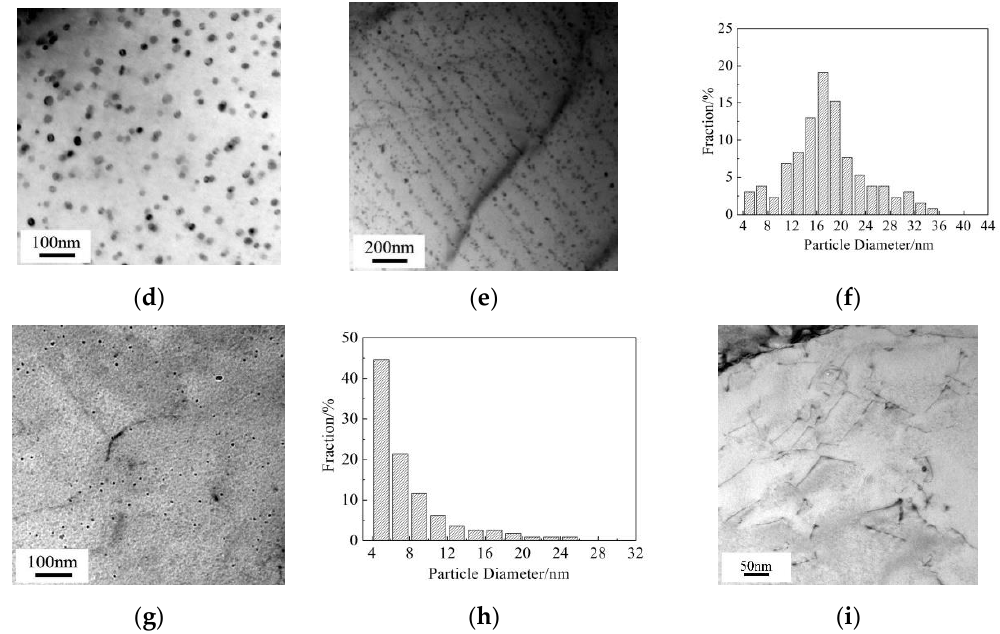
Figure 4. TEM images and histograms showing size distribution of dispersed Cu particles in ferrite for Cu-bearing steel. ( a – c ) 0.05 °C/s, ( d – f ) 0.2 °C/s, ( g , h ) 5 °C/s, ( i ) as-quenched condition in bainite.